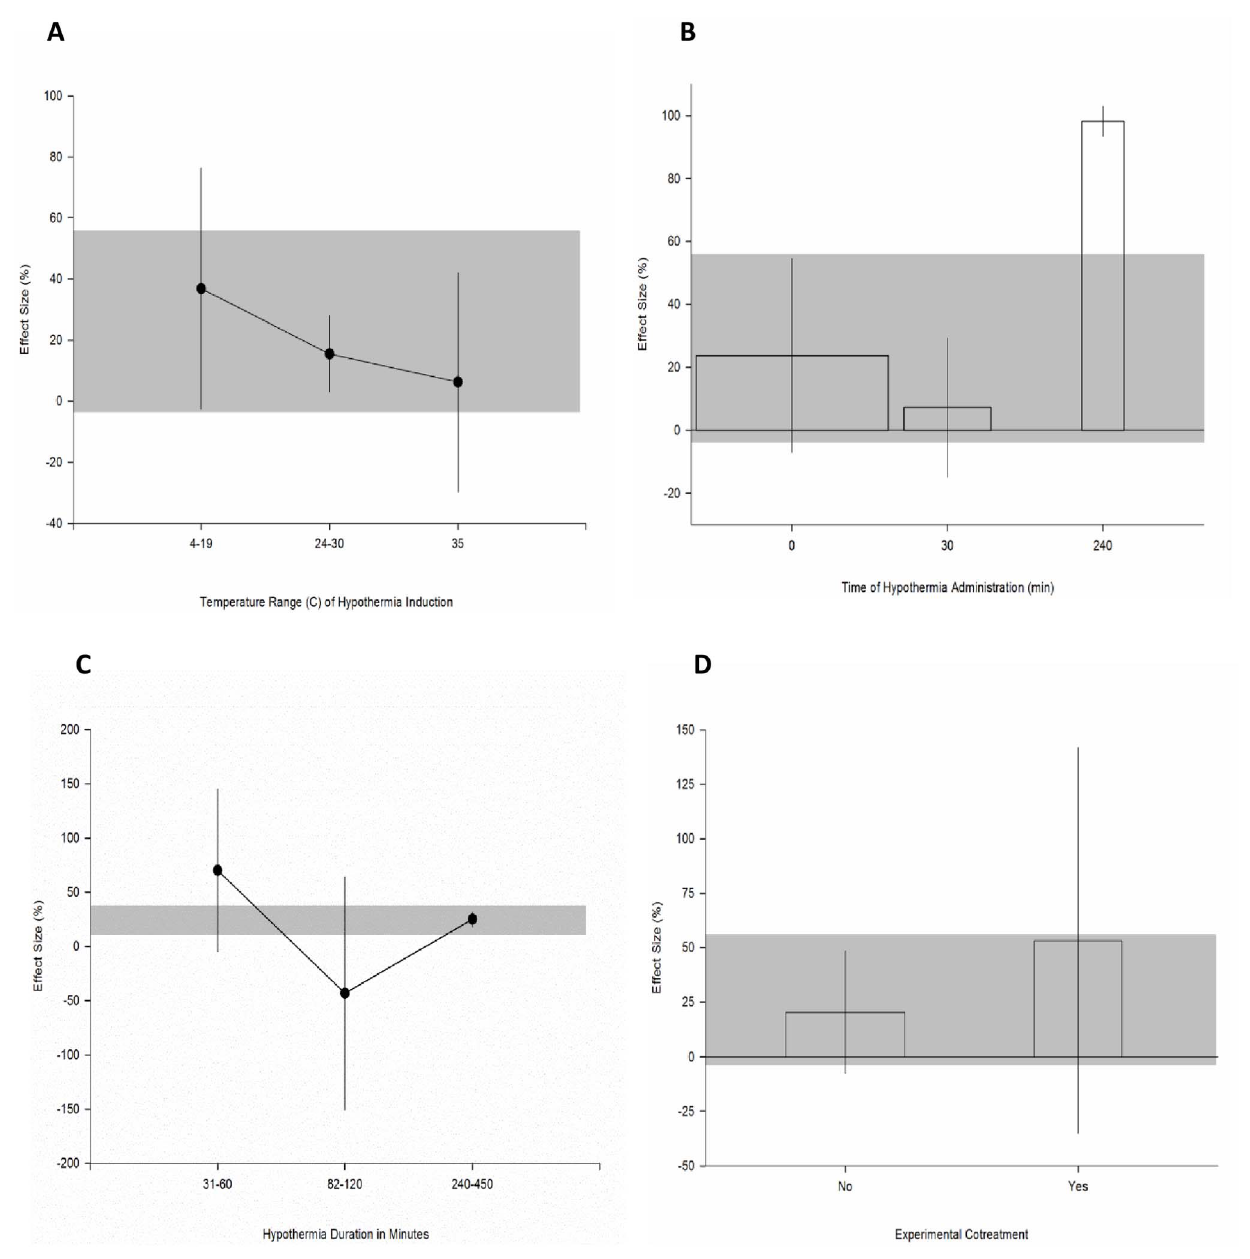
Figure 7. Treatment specific parameters of regional hypothermia experiments. Effect of ( A ) temperature range of hypothermia induction, ( B ) time of hypothermia administration, ( C ) duration of hypothermia and, ( D ) experimental cotreatment on the effect size reported within experiments employing regional hypothermia. The shaded gray bar represents the 95% confidence limits of the global estimate. The vertical error bars represent the 95% confidence intervals for the individual estimates. The width of each bar reflects the log of the number of animals contributing to that comparison. Each stratification accounts for a significant proportion of the heterogeneity observed between studies.